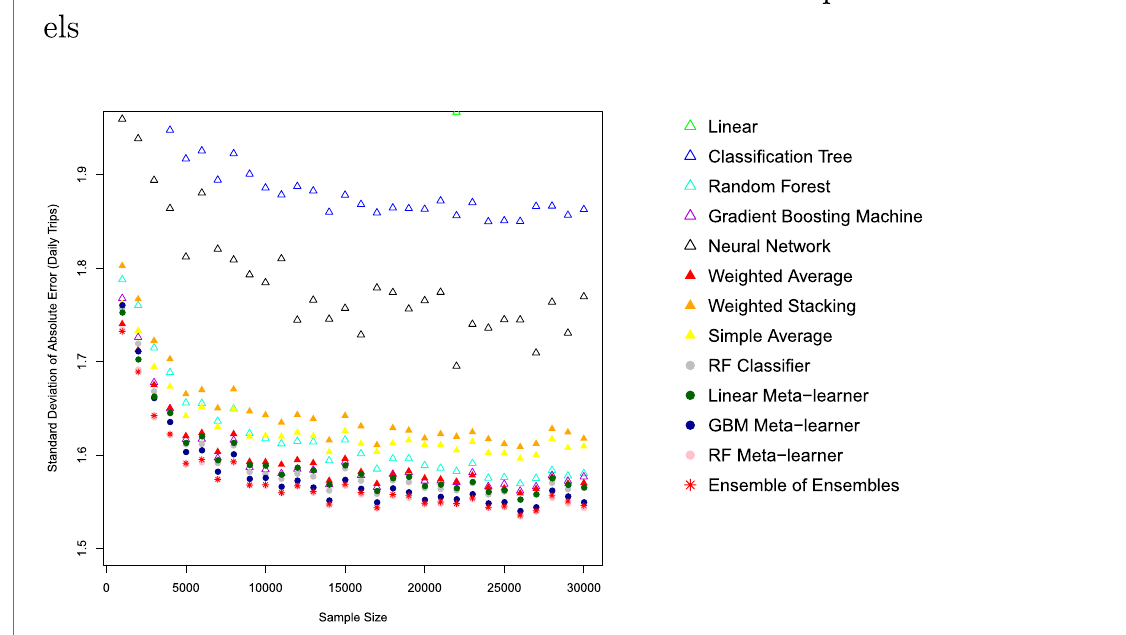
Frontiers in Future Transportation |